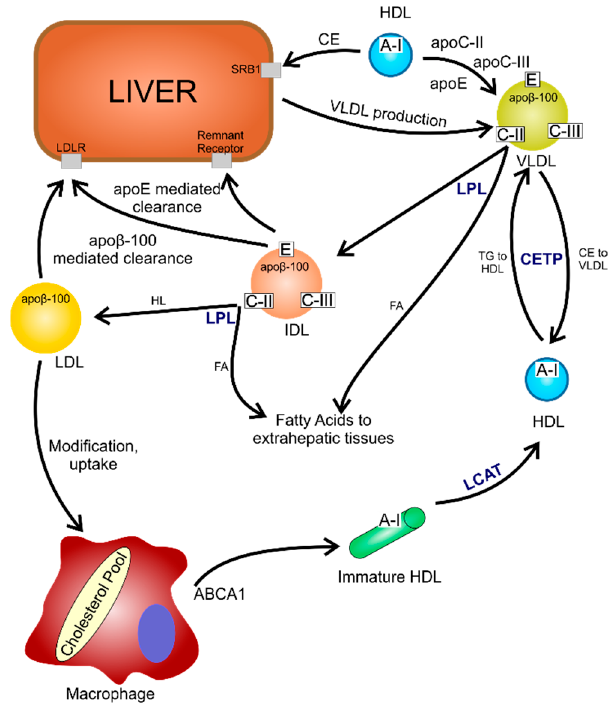
Figure 1. Mechanism of the atherosclerotic process.